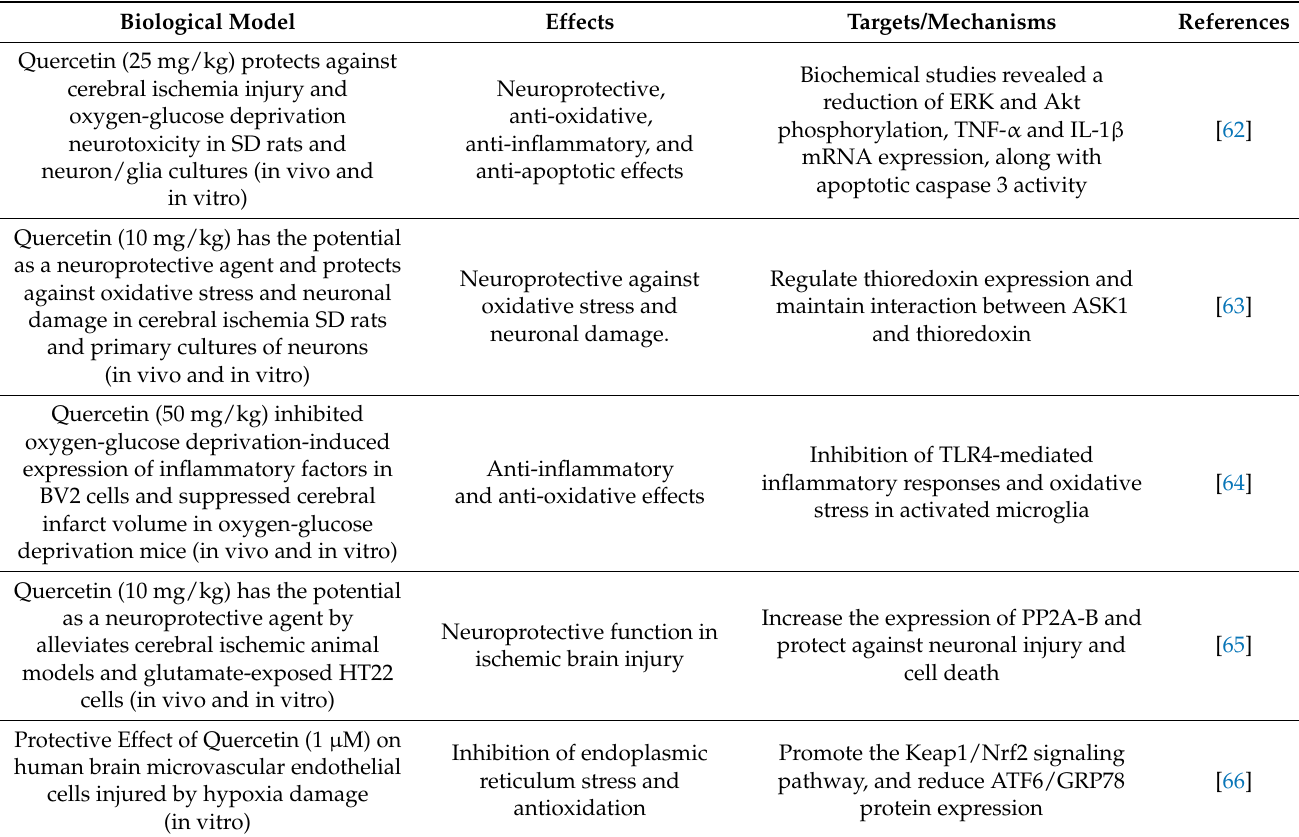
Table 3. Quercetin has been shown to have neuroprotective and anti-inflammatory effects in stroke. Biological